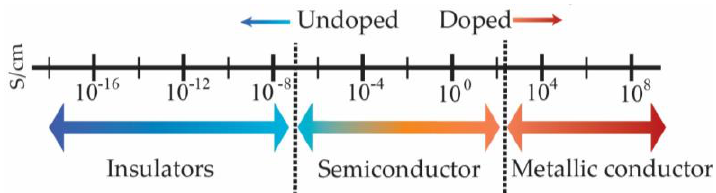
Figure 5. The general conductivity range of conducting polymers (CPs).